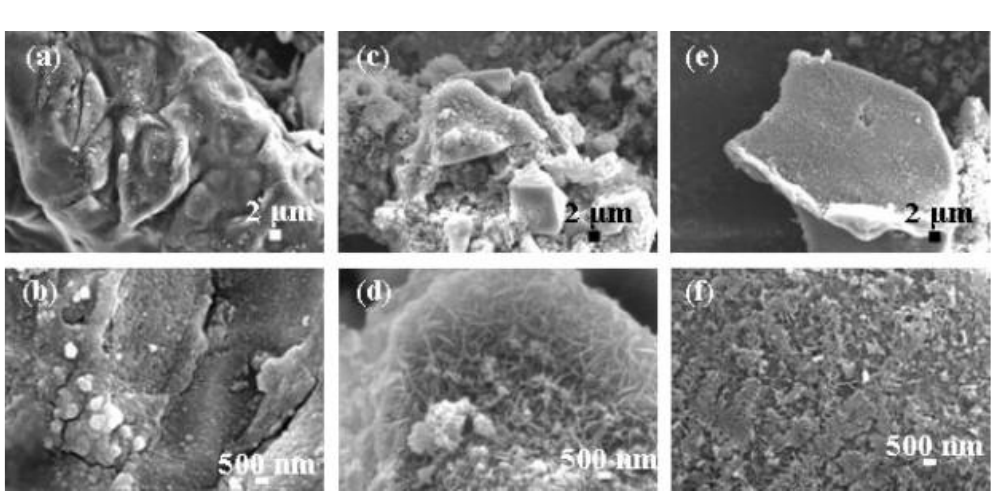
Figure 9. SEM micrographs of the cellulose/calcium silicate nanocomposites synthesized in ( a , b ) the starting ionic liquids, ( c , d ) the once-recycled ionic liquids, and ( e , f ) the twice recycled ionic liquids